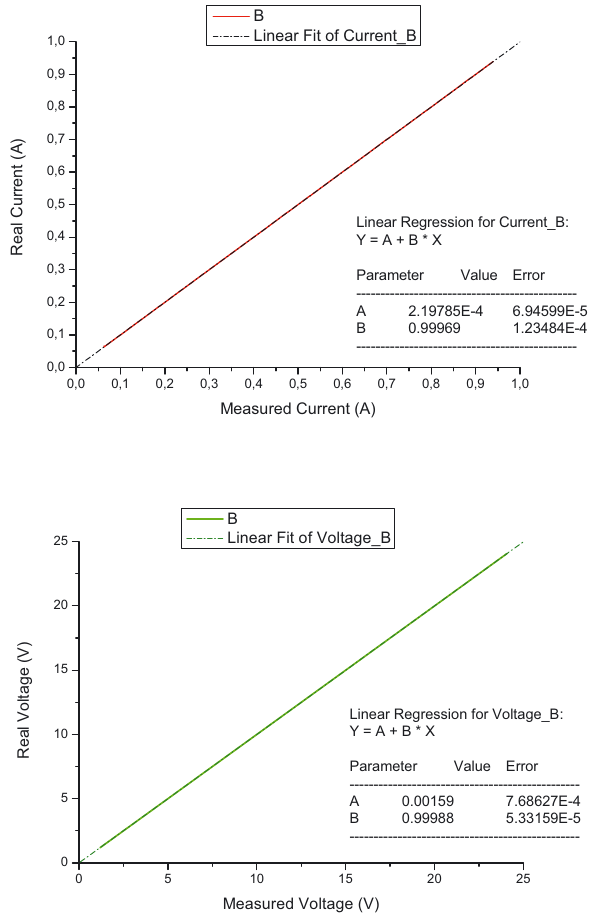
Fig. 10. Calibration curves for current and voltage sensors.